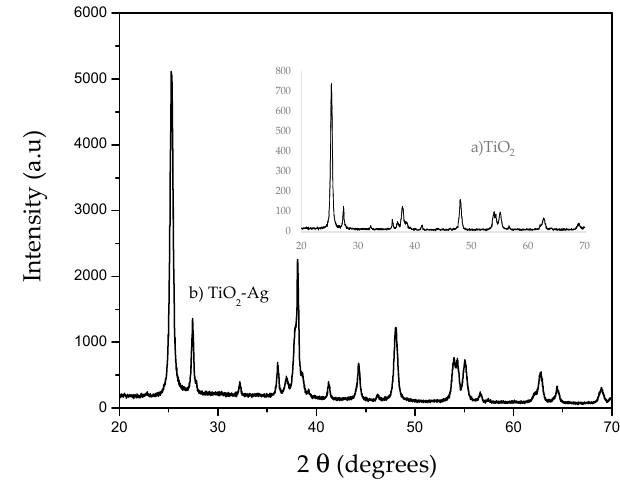
Figure 2. X-ray diffraction pattern of the silver nanoparticle-modified catalyst ( b ) compared to the commercial catalyst ( a ); different intensities are shown for the commercial catalysts that are attributed to the metallic silver.